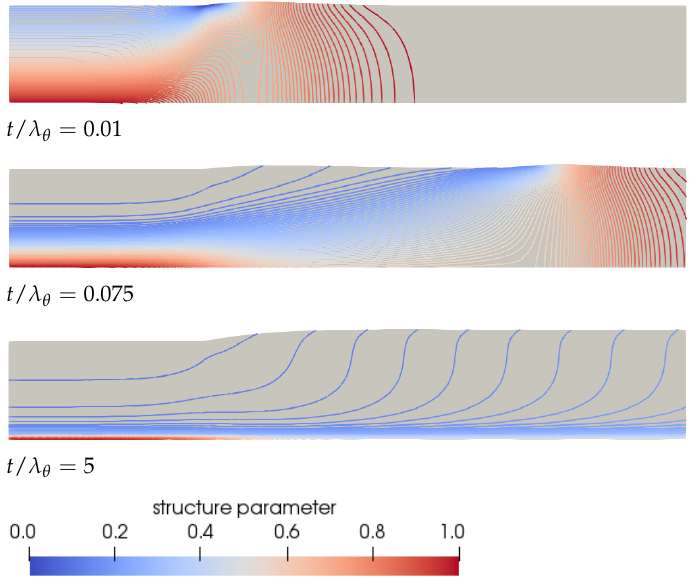
Figure 15. Contour plots of the structure parameter ξ predicted by the rate-controlled approach for λ θ = 10 λ avg and γ ∗ = 1 for different instances in time.